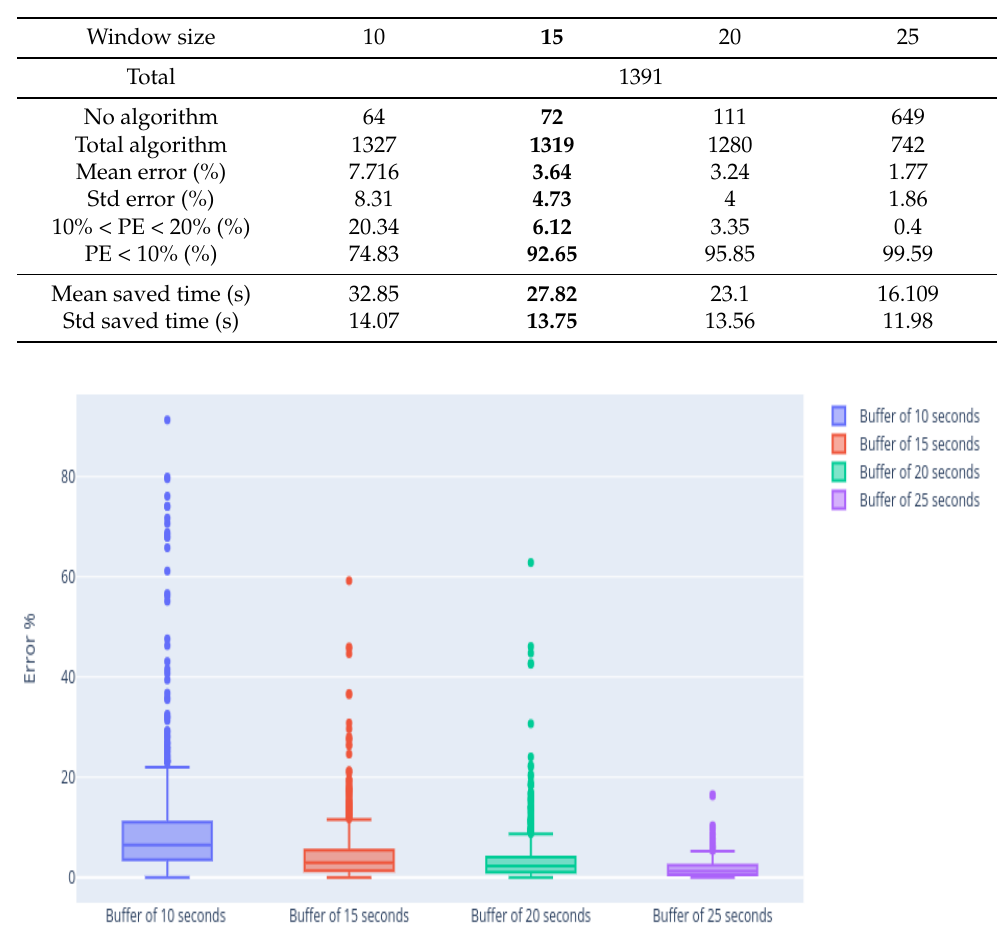
Table 2. Model results with different window size.